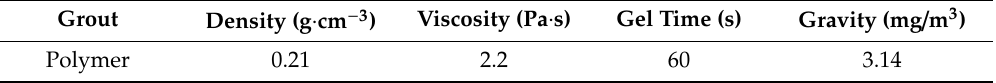
Table 1. Measured properties of the tested